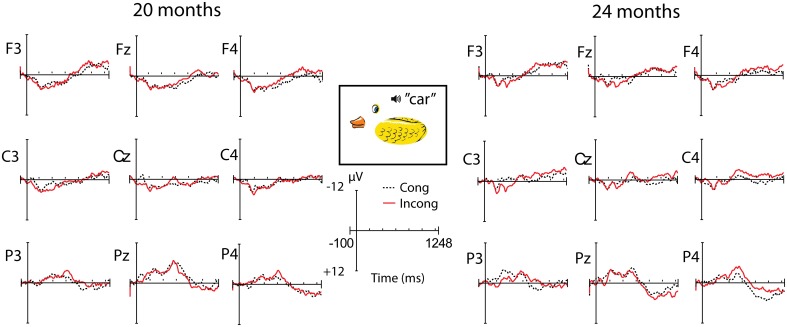
ERPs to congruous and incongruous words presented with detail pictures, at 20 and 24 months.